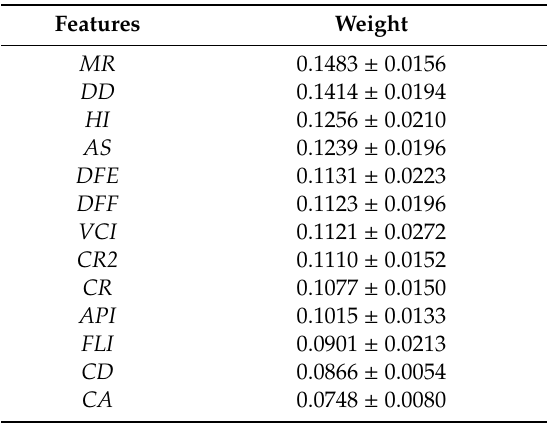
Table 5. Calculated importance of the